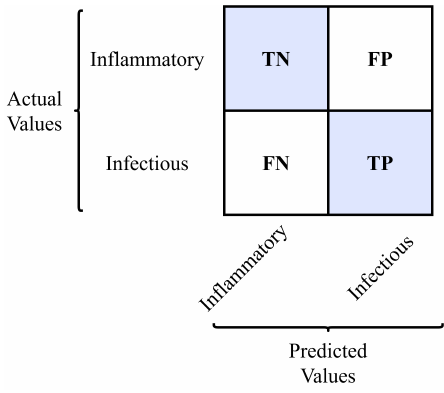
Figure 6. Confusion Matrix for SF classification.